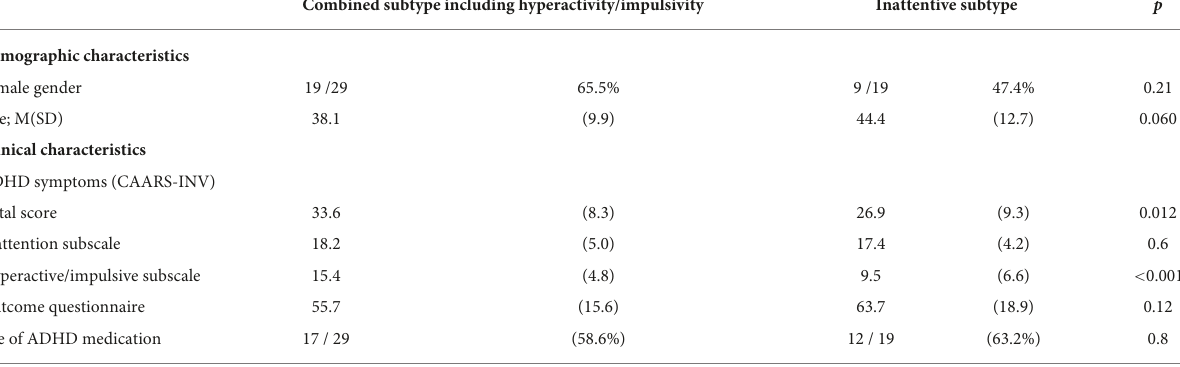
TABLE 2 Baseline demographic and clinical characteristics compared between those patients diagnosed with subtypes with and without